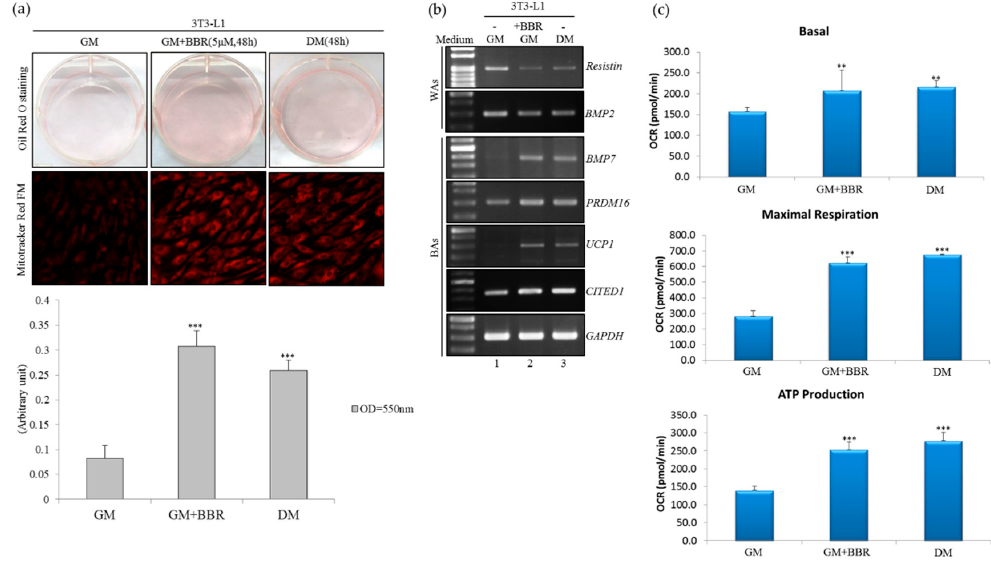
Figure 1. Berberine (BBR) treatment-enhanced beige adipogenesis of 3T3-L1 cells. ( a ) 3T3-L1 cells were cultured in the growth medium, the BBR-supplemented growth medium (5 µ M), or the Rosiglitazone-supplemented di ff erentiation medium for 48 h, followed by Oil-Red-O staining (upper) and Mitotracker Red FM staining (lower). The bar graph presents the spectrophotometric analysis of Oil-Red-O dye extracted from the stained cells. ( b ) Total RNAs extracted from in vitro cultured cells were subjected to RT-polymerase chain reaction (PCR) assays using specific primer sets, as listed in Supplementary Table S1. ( c ) 3T3-L1 cells were cultured in the growth medium, the BBR-supplemented growth medium (5 µ M), or the Rosiglitazone-supplemented di ff erentiation medium for 48 h, followed by the bioenergetic analyses using a Seahorse XF24 Bioanalyzer ( n = 4). The bar graphs present the basal oxygen consumption rate (OCR), maximal OCR, and ATP production rate of cultured cells. Quantitative results are presented as the mean ± SD ( n = 4), and statistical significance was calculated using the student unpaired t -test (** p < 0.01; *** p < 0.005).